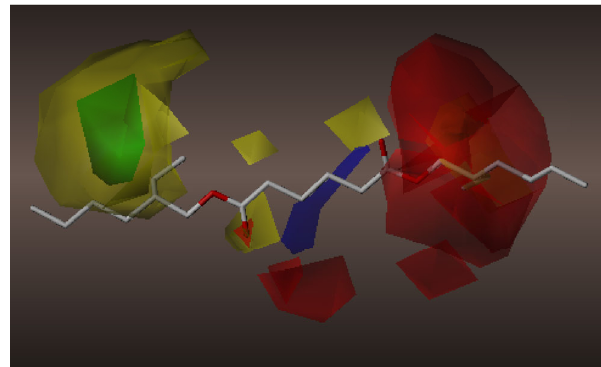
Fig. 43 CoMFA contour diagram for friction with embedded bis(2- ethylhexyl) adipate as reference for both steric and electrostatic fields. Green and yellow regions show where steric bulk is favored and disfavored, respectively. Blue region shows where positive charge is favored while red region shows where negative charge is favored.